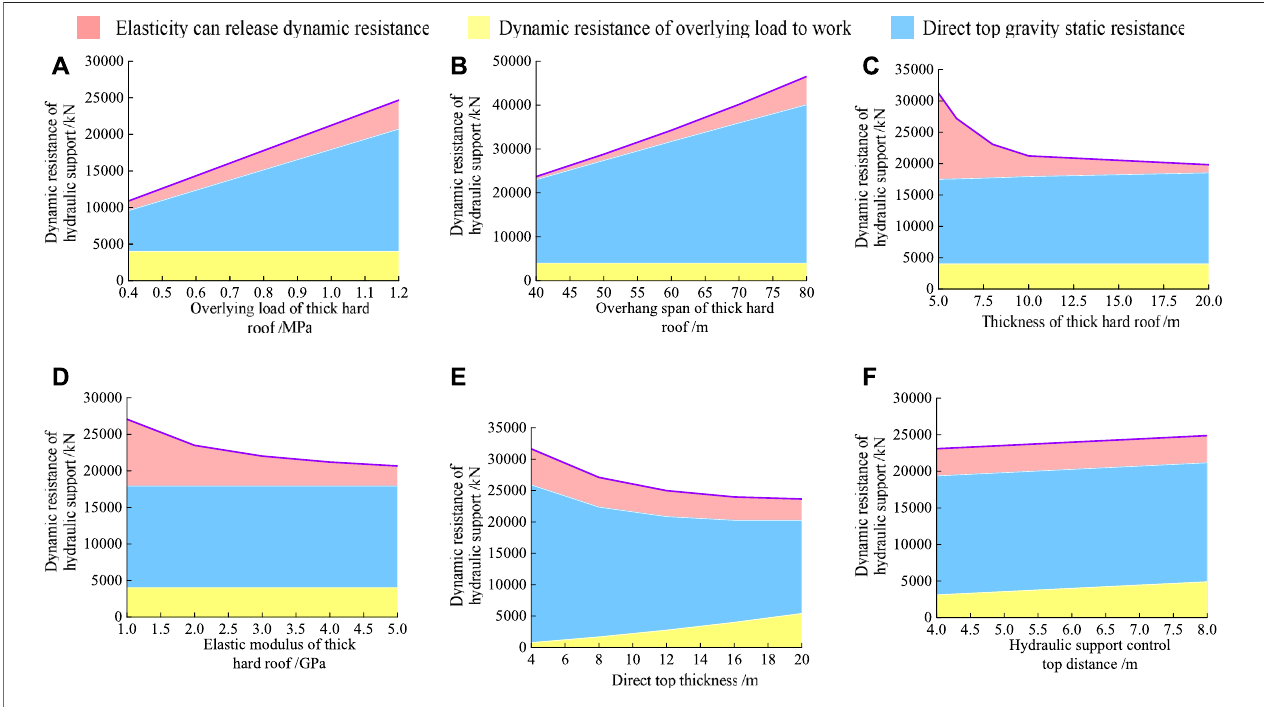
FIGURE10| In fl uencecharacteristicsofthedynamicpressureoftheworkingfacehydraulicsupportunderthickhardroofconditions. (A) In fl uenceoftheoverlaying load on the thick hard roof. (B) In fl uence of the thick hard roof span. (C) In fl uence of the thick hard roof thickness. (D) In fl uence of the thick hard roof on the elastic modulus. (E) In fl uence of the direct top thickness. (F) In fl uence of the hydraulic support top control distance.